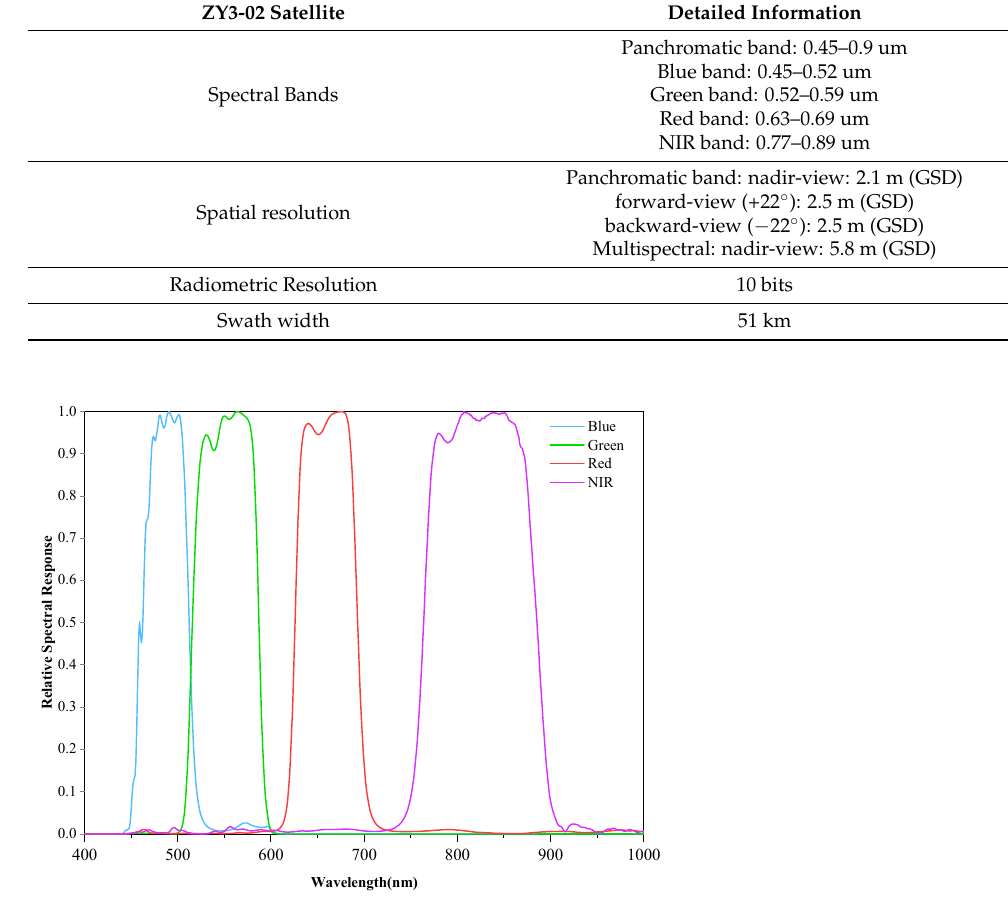
Figure 1. Details of normalized spectral response function of multispectral sensor (MUX).